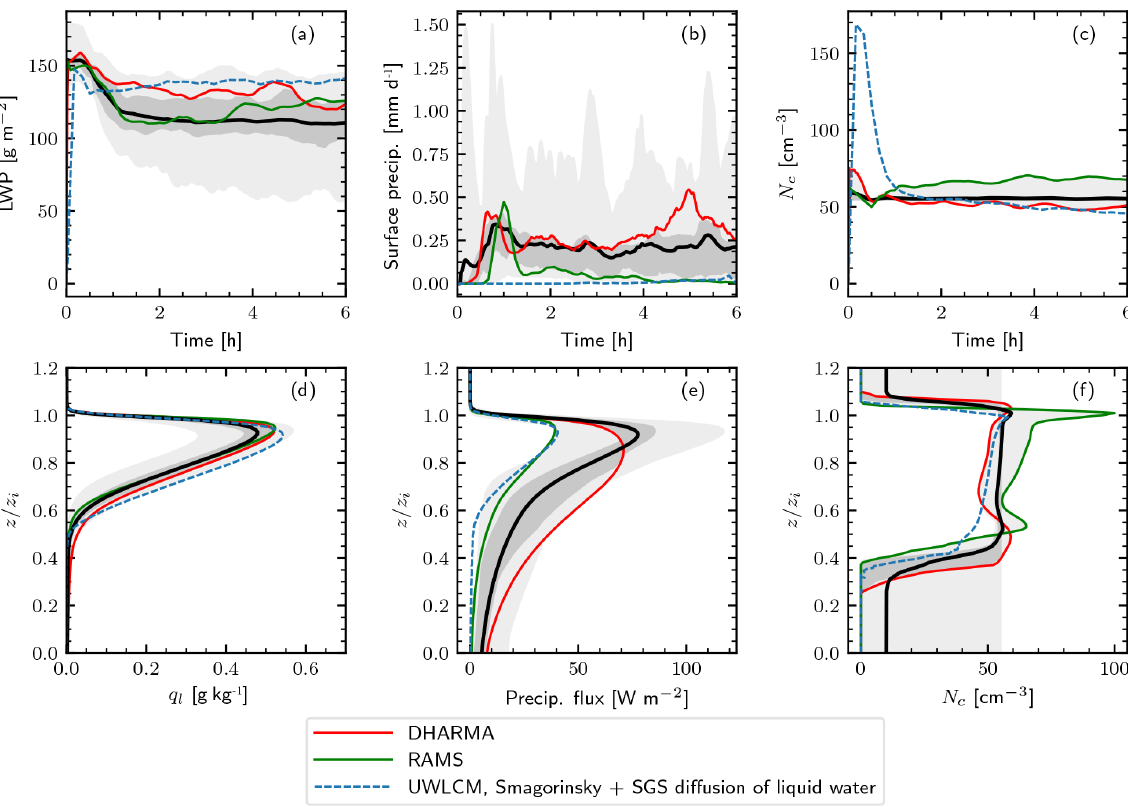
Figure 7. Selected time series of domain averages ( a – c ) and vertical profiles ( d – f ) from the 3-D UWLCM and the two models with bin microphysics that took part in the Ackerman et al. (2009) intercomparison: DHARMA and RAMS. From the two DHARMA runs carried out in the intercomparison, the DHARMA_BO run is shown, because it uses a coalescence efficiency closer to unity, which is the value used in UWLCM and RAMS. Profiles are averaged and scaled as in Fig. 4. Reference results from all models discussed in Ackerman et al. (2009) are depicted as in Fig.